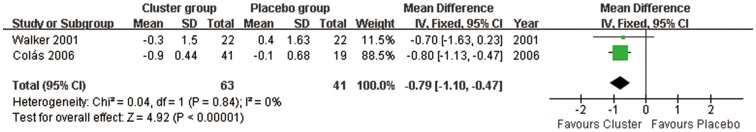
Meta-analysis of the RCTs comparing overall quality of life between cluster group and placebo group.